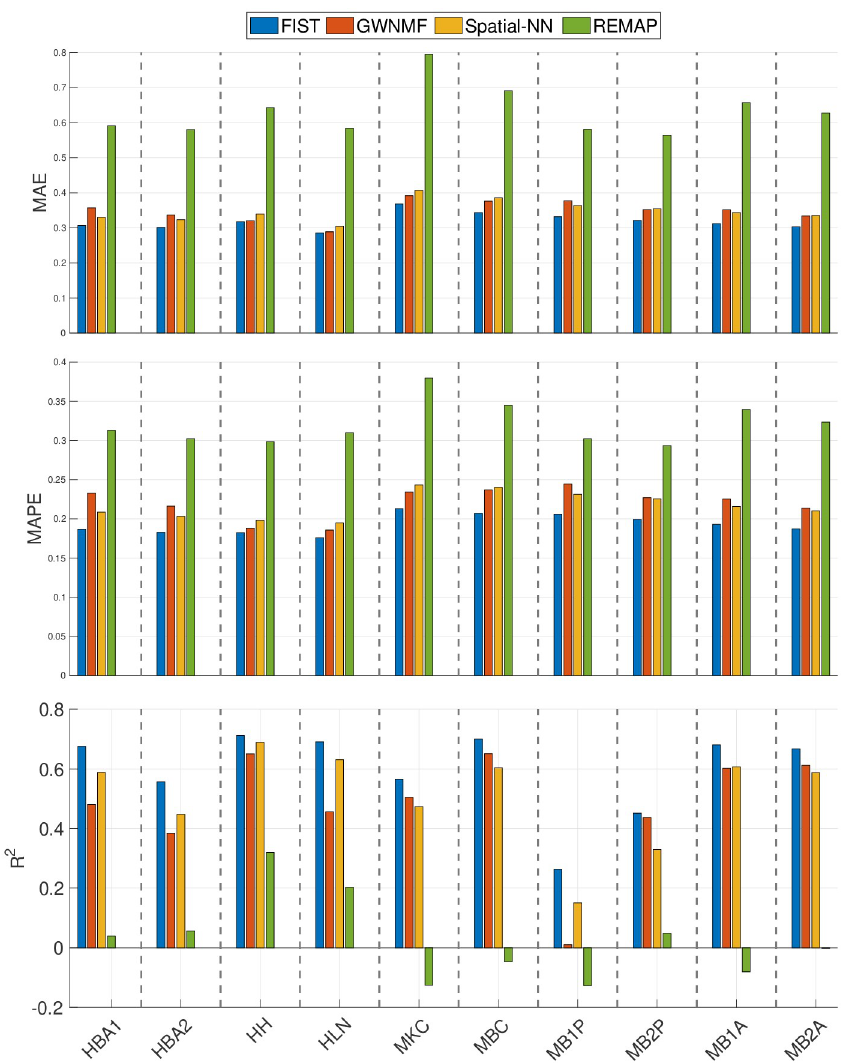
Fig 2. Spot-wise cross-validation on 10x Genomics data. The performances of the four compared methods on the 10 tissue sections are measured by 5-fold cross-validation. Each bar shows the mean of the imputation performance of one method on all the spatial spots. The result on each of the 10 datasets is shown in one vertical column separated by dashed lines. The means are also compared between FIST and each of the baseline methods in S1 Table by paired- sample t